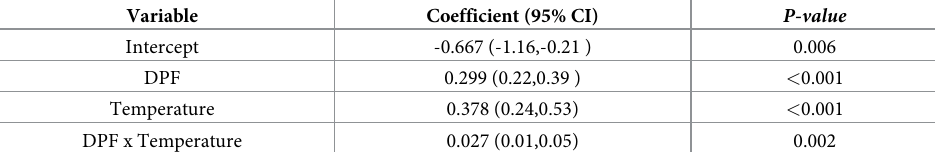
Table 2. Coefficients from the logistic model for the probability of ZIKV transmission as a function of time and temperature.